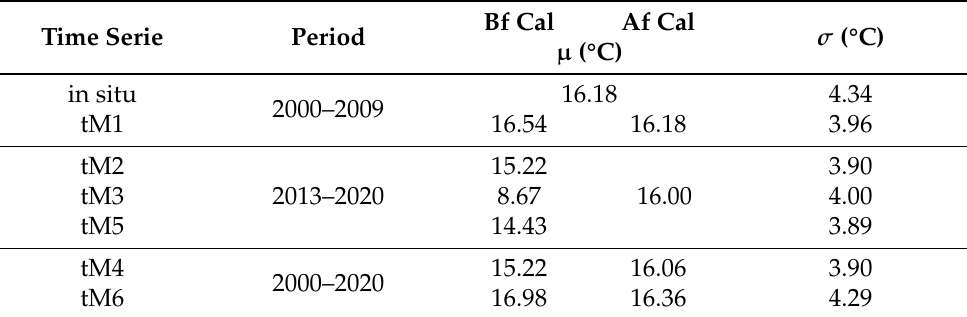
Table 6. Mean ( µ ) and standard desviation ( σ ) of LSWT time series before (Bf cal) and after (Af cal) calibration. Average values at Laguna Grande sampling stations (St.: D, C y